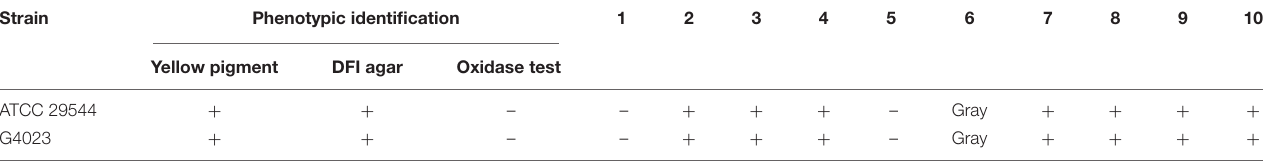
Strain Phenotypic